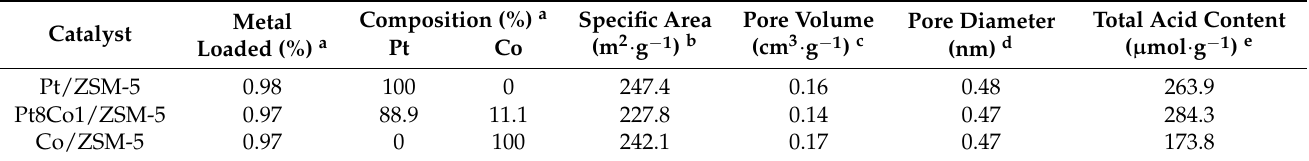
Table 1. Physical properties of the as-prepared Pt8Co1/ZSM-5-AT, Pt/ZSM-5-AT and Co/ZSM-5-AT catalysts.